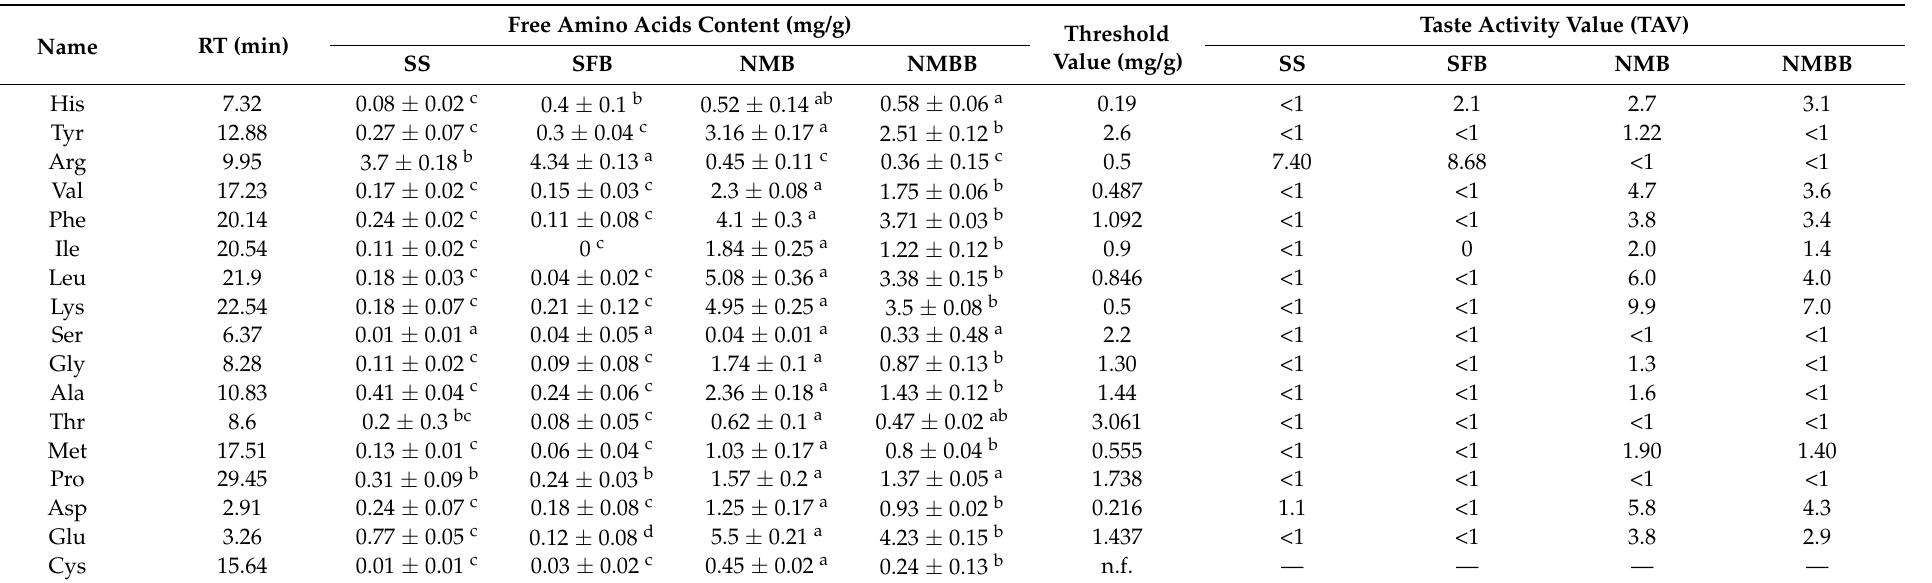
Table 2. Content of free amino acids and taste activity value (TAV) in SS, SFB, NMB and NMBB